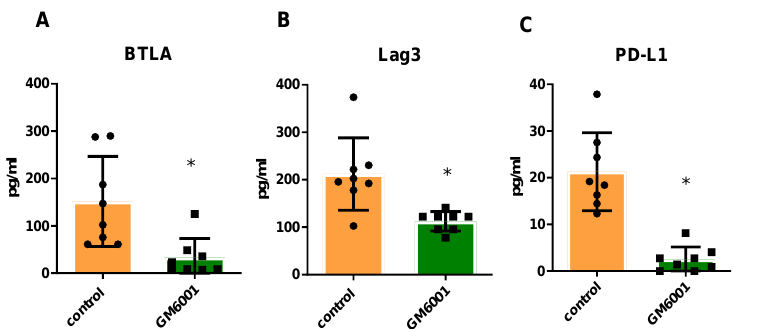
Figure 4. Checkpoint molecule cleavage from CD tissues is inhibited by GM6001 MMP inhibitor where the multiplex array of tissue supernatants indicates that ( A ) BTLA, ( B ) Lag2, and ( C ) PD-L1 are decreased when tissues are treated with GM6001. N = 8, * p < 0.05.